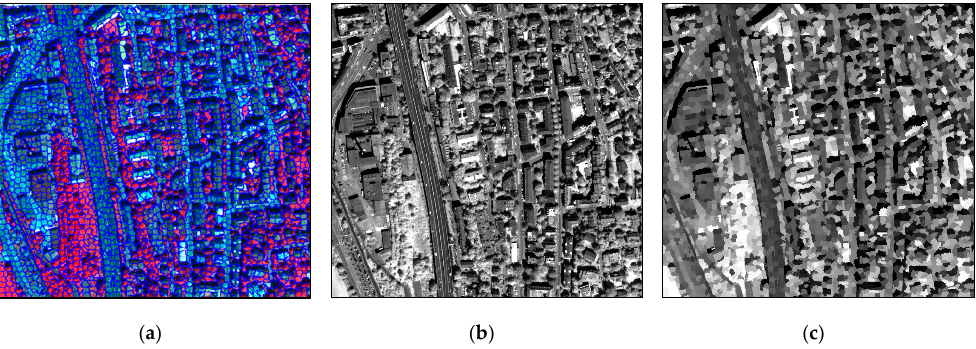
Figure 5. The segmentation result in ( a ) and guidance images for comparison purposes: ( b ) in the original pixel-based GF and ( c ) in the proposed superpixel-based GF (Zh1).